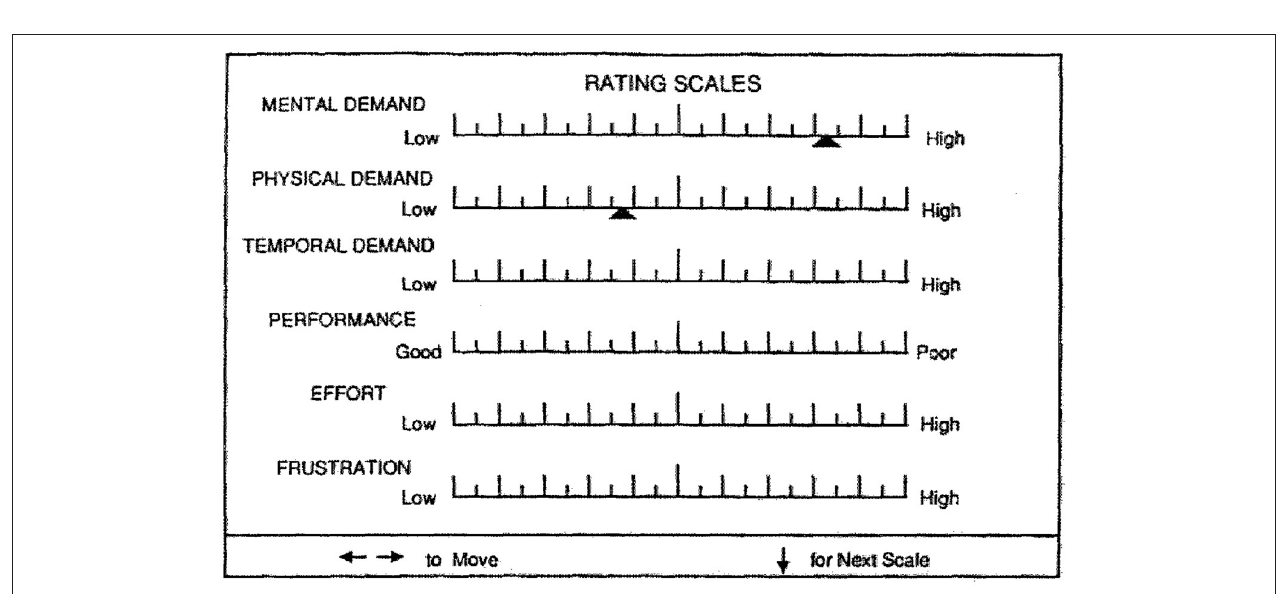
FIGURE 2 | The NASA Task Load Index